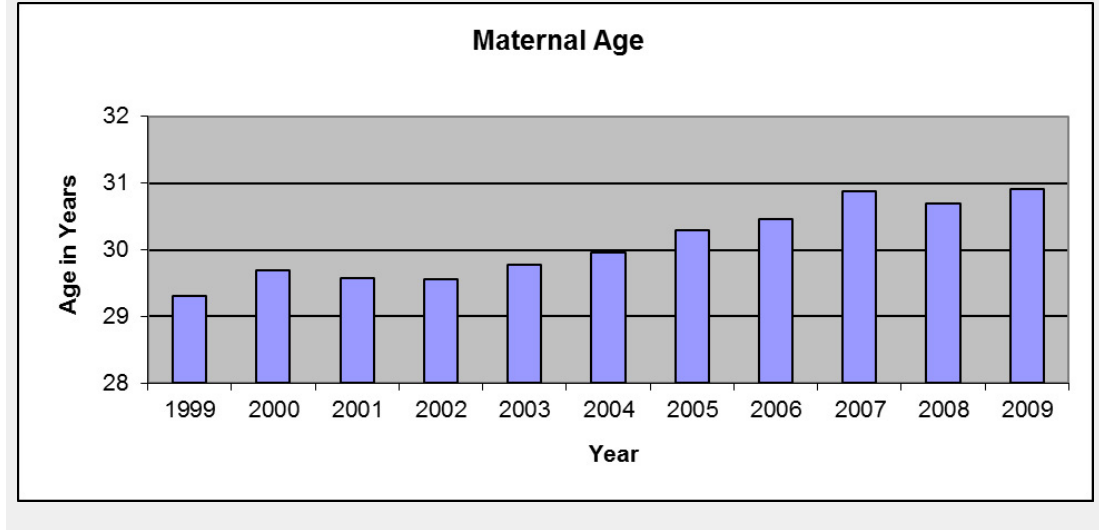
Figure 6 The maternal age increased significantly from 29.3 to 30.9 years in 2009 (p <0.0001).